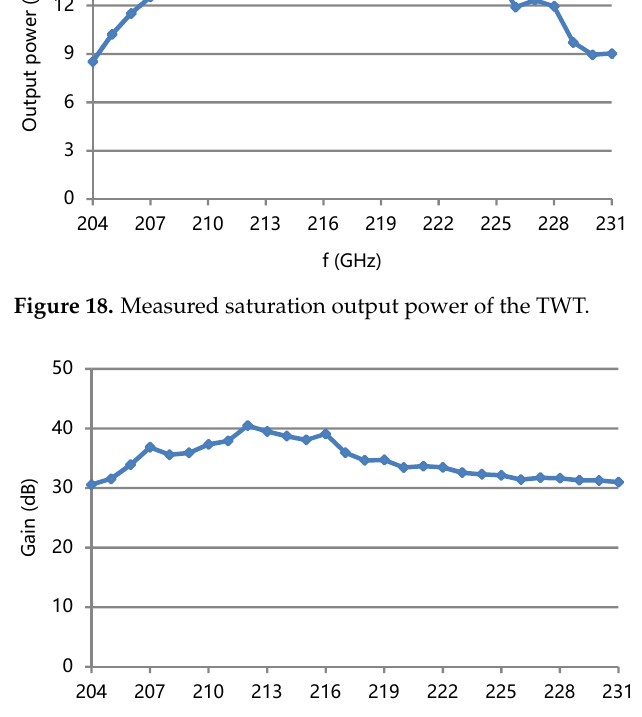
Figure 18. Measured saturation output power of the TWT .